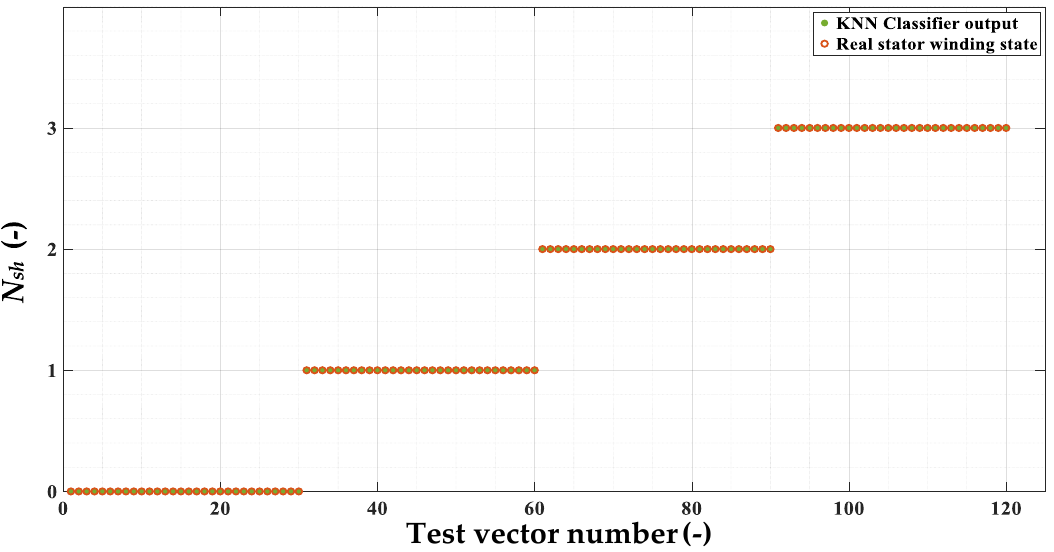
Figure 12. KNN stator winding fault classifier response to the test data set. Off-line verification tests showed that this classifier provides high efficiency in the detection and classification of inter-turn short circuits. For this reason, it was decided to continue experimental tests during the on-line operation of the drive system. The flowchart of the proposed on-line fault classification algorithm is shown in Figure 13. The diagnostic application responsible for the data acquisition and signal pre-processing (calculation and spectral analysis of i 1 and i 2 ) was developed in the Lab- VIEW programming environment. The script to call pre-trained KNN stator winding state classifier model was prepared in MATLAB.